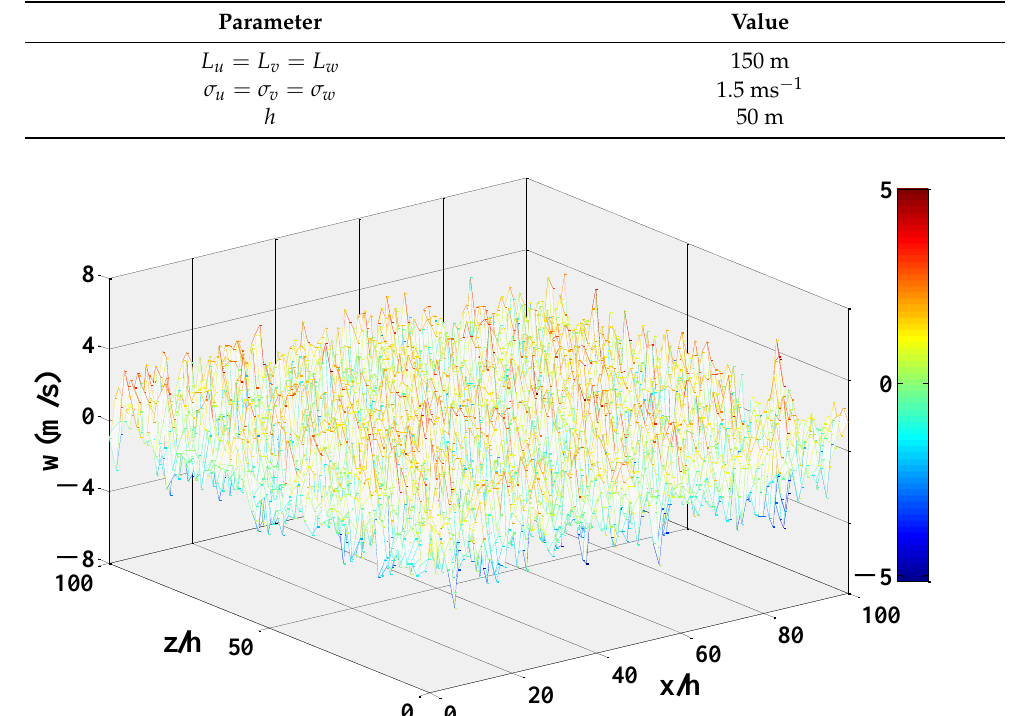
Table 3. Parameters of atmospheric turbulence model [30].